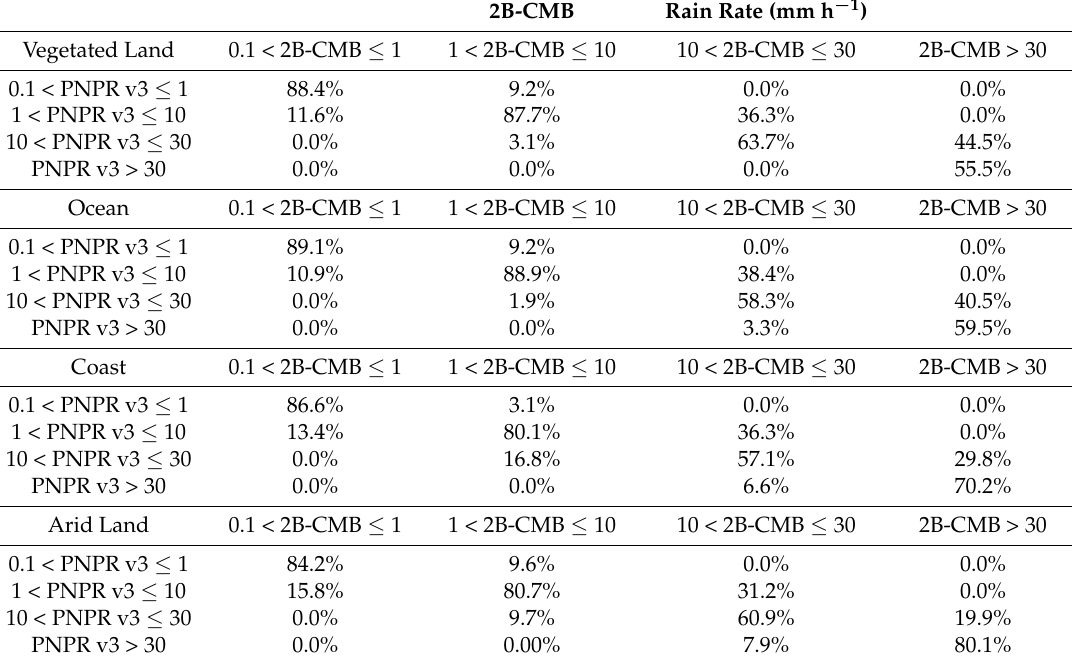
Table 6. Contingency table of PNPR v3 retrievals relative to 2B-CMB combined product estimates (pixel based).